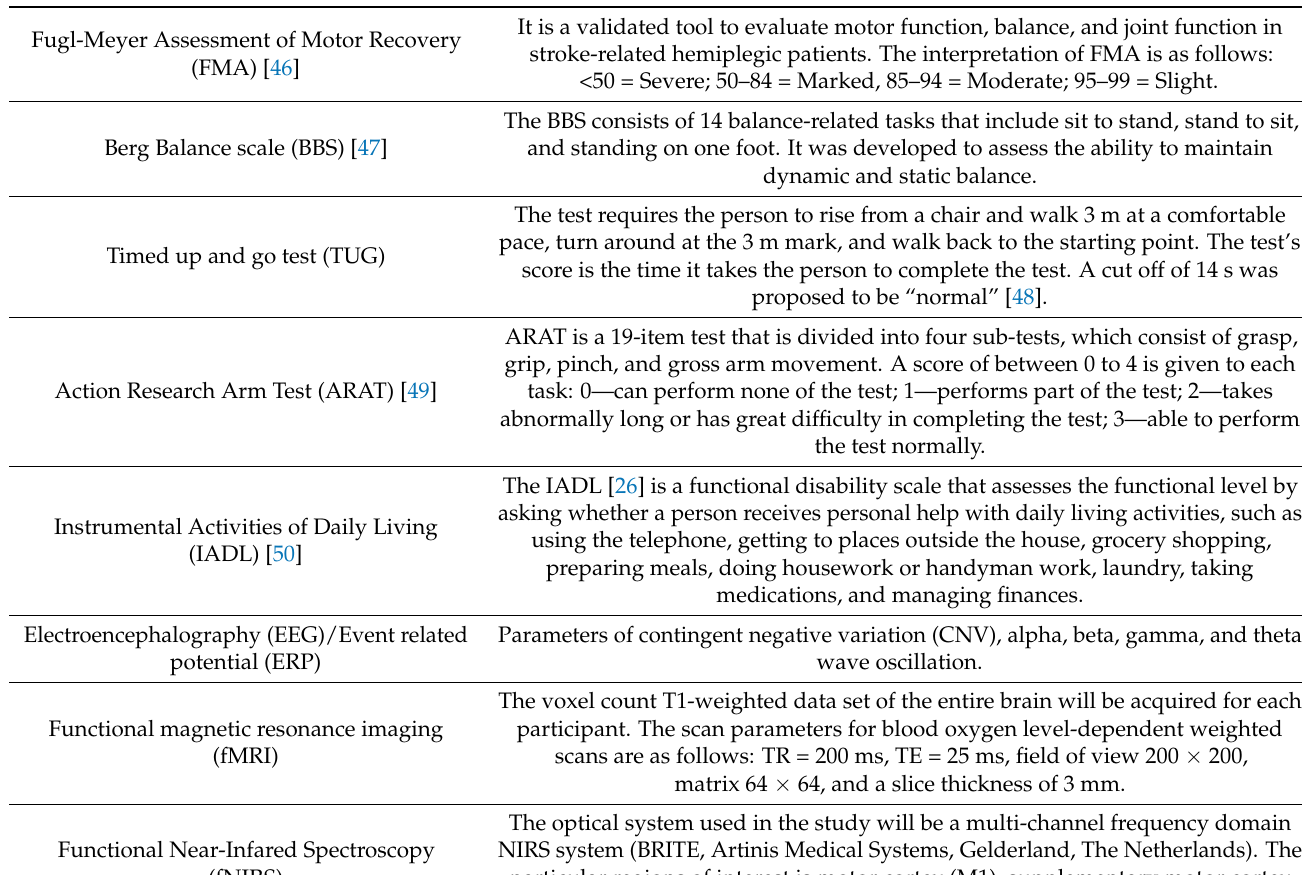
Table 1. A brief description of each of the secondary outcome measure that will be recorded at all participating centres. Fugl-Meyer Assessment of Motor